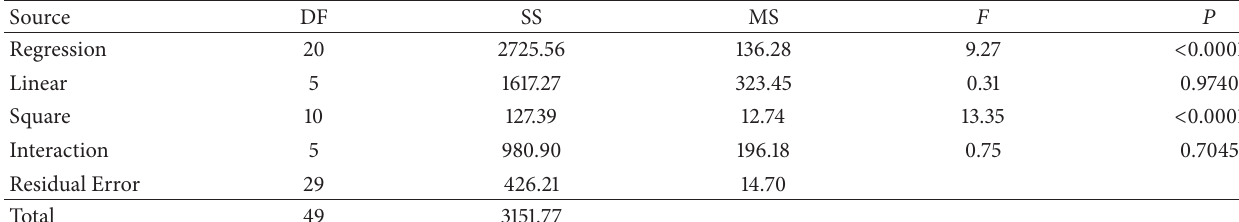
Table 3: ANOVA table for response surface function on bioflocculation efficiency.